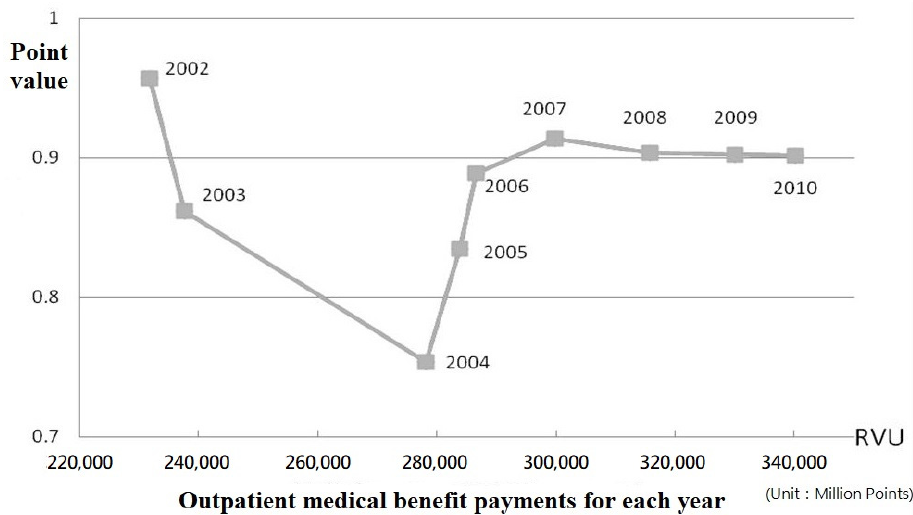
Figure 1. The trend of floating point value in the healthcare sector from 2002 to 2010.